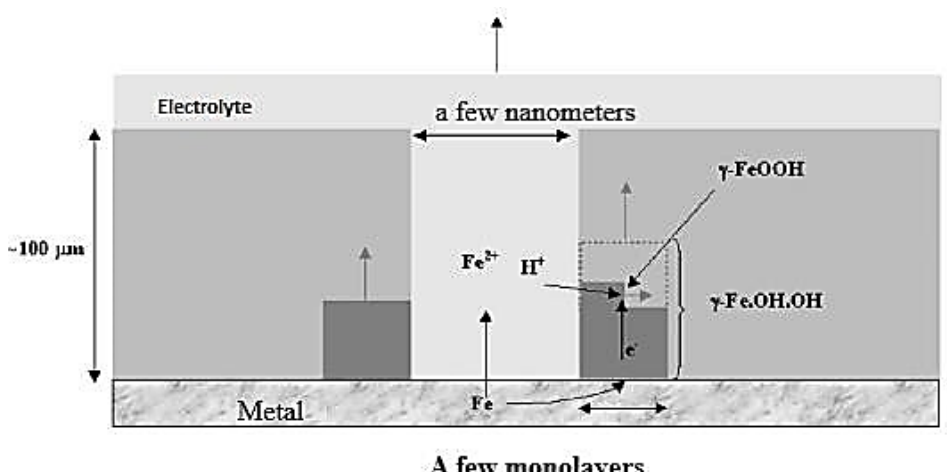
Figure 5. Representation of the phenomena involved in the wetting phase.